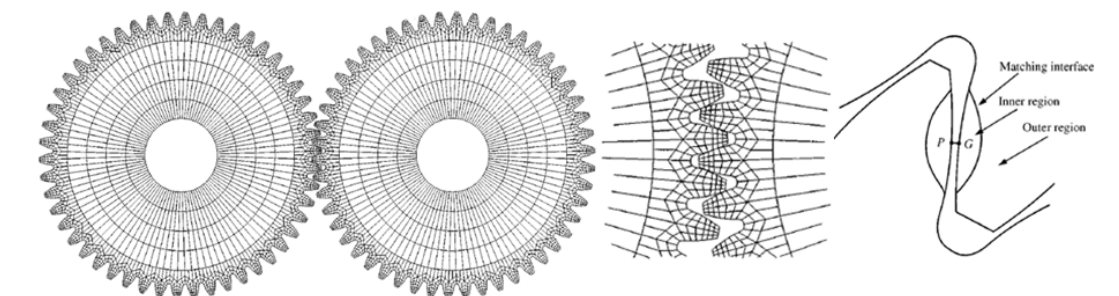
Figure 9. Coupled FE/Contact mechanics model from